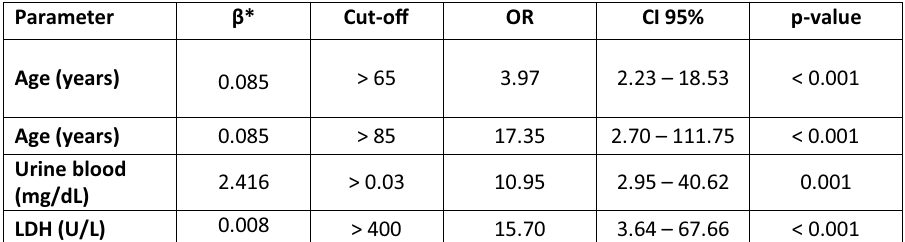
Figure 4. Cut-off values and ROC curve of age, urine blood and LDH activity in serum for COVID-19 mortality